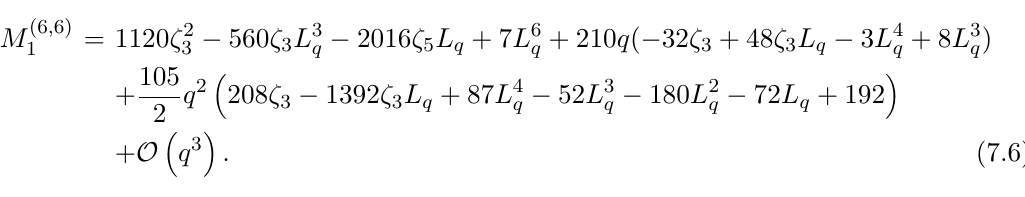
at six loops with numerical results from